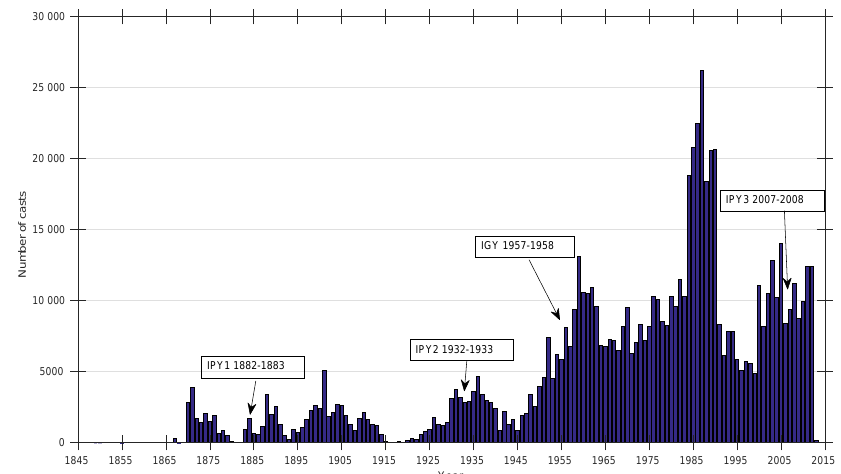
Figure 3. Time series of number of casts per year in WOD13. Notable special observing periods include the International Polar Years (IPY; 1882–1883, 1932–1933 and 2007–2008), as well as the International Geophysical Year (IGY; 1957–1958).